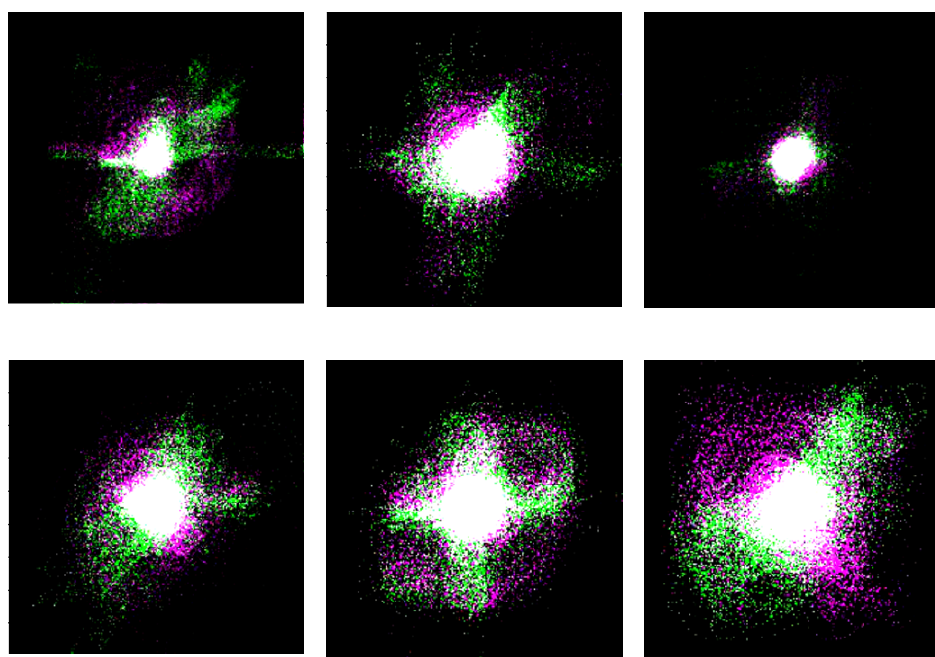
Figure 6. chaograms of six PCG signals: on the top row, 3 normal cases, and, on the bottom row, 3 abnormal